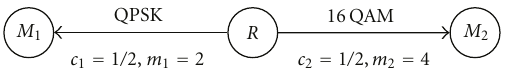
of them are selected by taking the tradeo ff between the number of links and the actual rate [9]. This opportunistic scheduling, however, cannot exploit the full power of